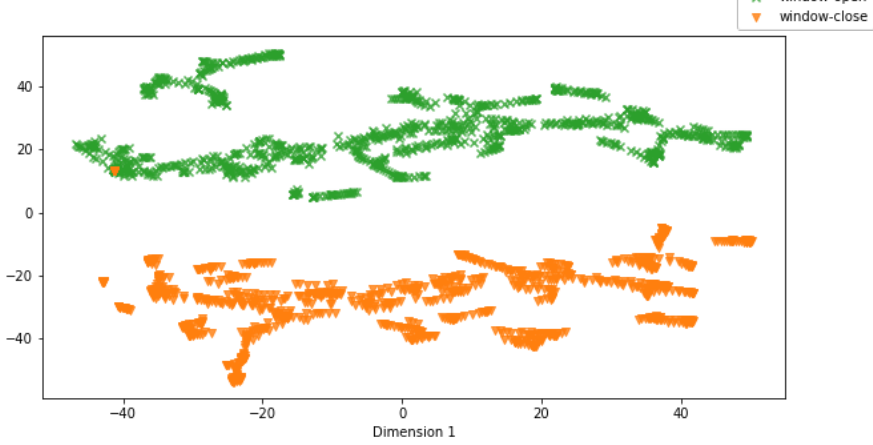
Figure 7. Visualization of clustering results on task embedding vectors z t mark different